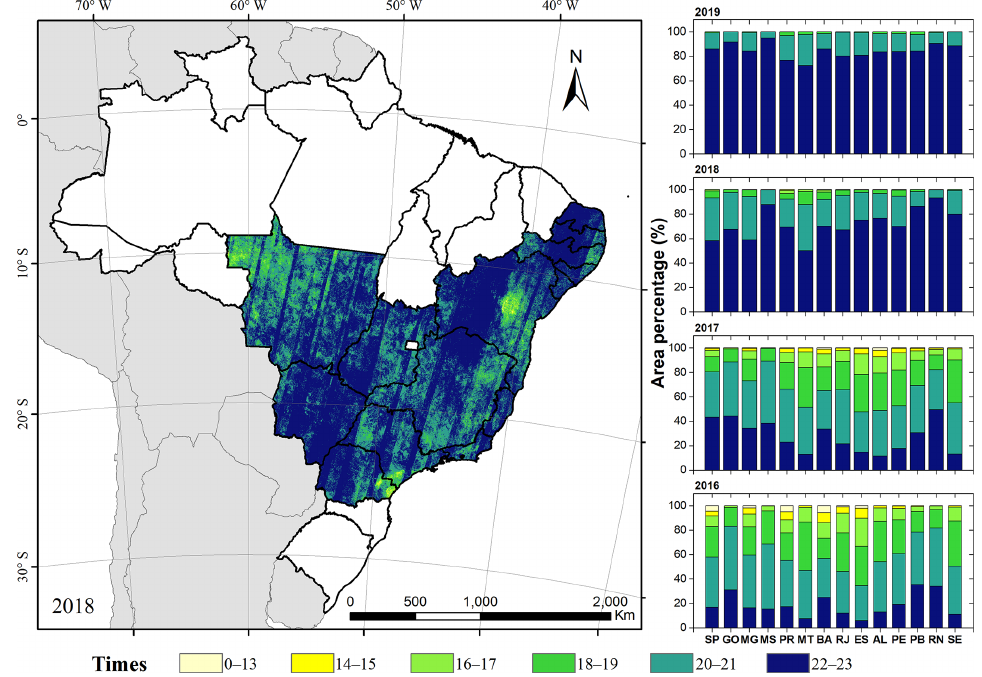
Figure 2. Times of good observations for the 16d composite satellite data over a year. Left: number of good observations in 2018. Right: area percentages of the number of good observations for each state from 2016–2019. The administrative boundary data were obtained from the